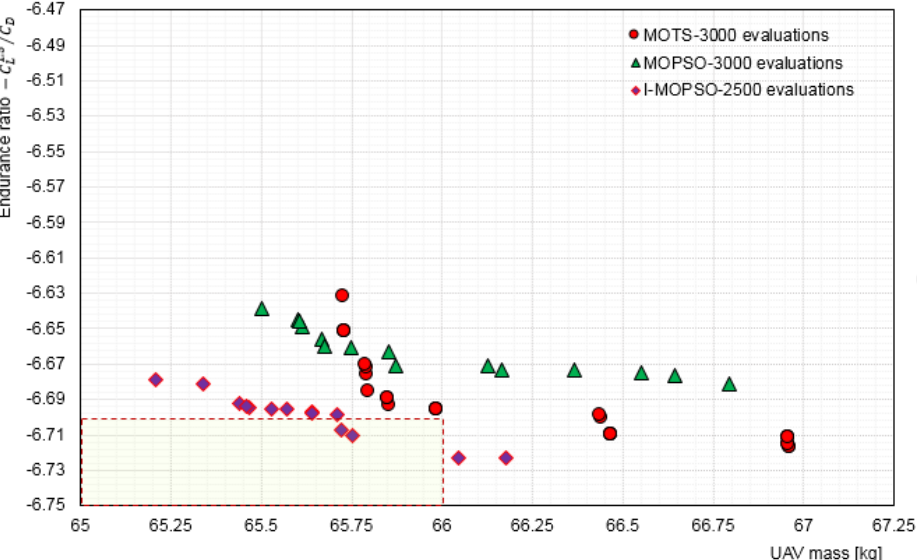
Figure 19. Comparison of Pareto front using MOTS and MOPSO for 3000 evaluations, and with I-MOPSO for 2500 evaluations. With the interactive approach it is possible to stop the run as and when the required solutions are